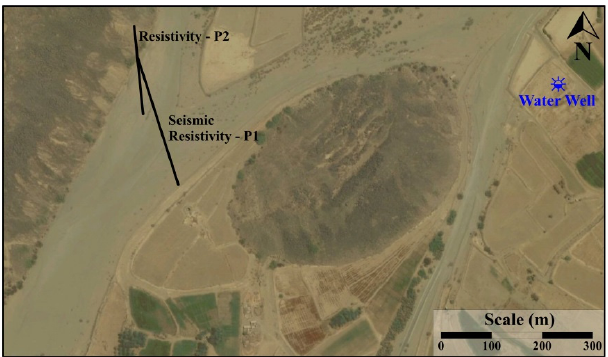
Figure 5. Locations of three geophysical profiles in Wadi Qidayd with both seismic refraction and resistivity profiles along tract P1 and only resistivity along tract P2. resistivity profiles along tract P1 and only resistivity along tract